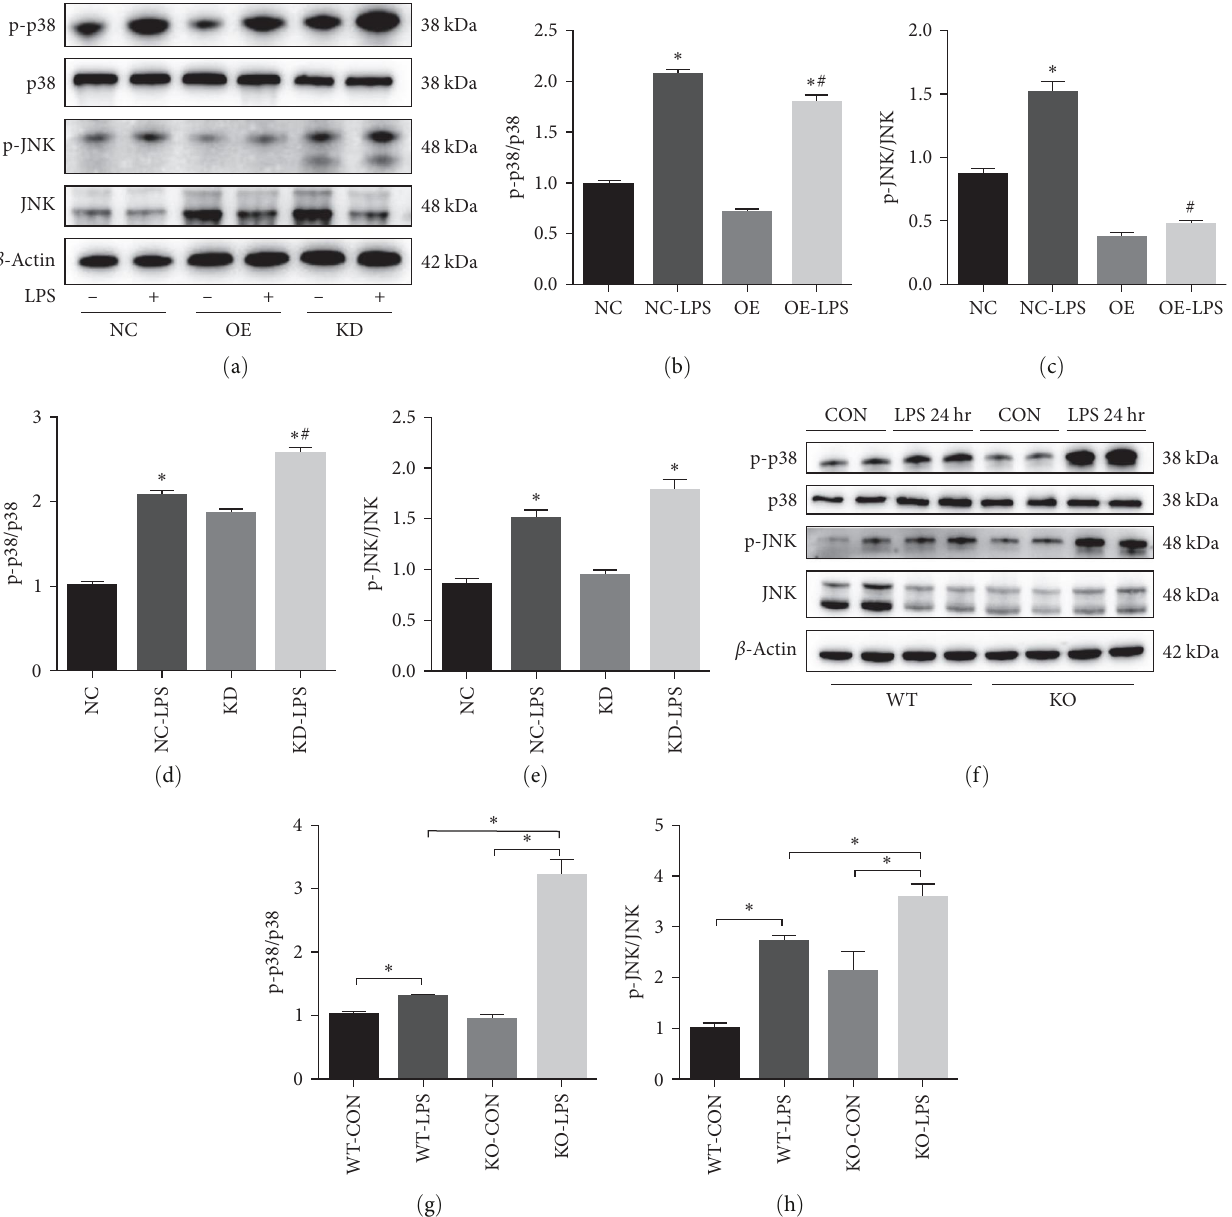
F IGURE 6: ALDH2 regulates MAPK signaling pathway after LPS administration: (a) representative western blots of p-p38, p38, p-JNK, JNK, and β -actin (loading control) in ALDH2 overexpression (OE), knockdown (KD), and control (NC) tubular epithelial cells (TECs) after LPS challenging; (b, c) quanti fi cation analysis of p-p38, p38, p-JNK, and JNK expression in OE vs . NC cells; (d, e) quanti fi cation analysis of p-p38, p38, p-JNK, and JNK expression in KD vs . NC cells; (f – h) representative western blots and quanti fi cation analysis of p-p38, p38, p-JNK, JNK, and β -actin (loading control) in WT and KO mice after LPS administration. All data are expressed as mean Æ SEM ( n = 6). ∗ P < 0 : 05 vs . NC or OE group. # P < 0 : 05 vs . NC LPS